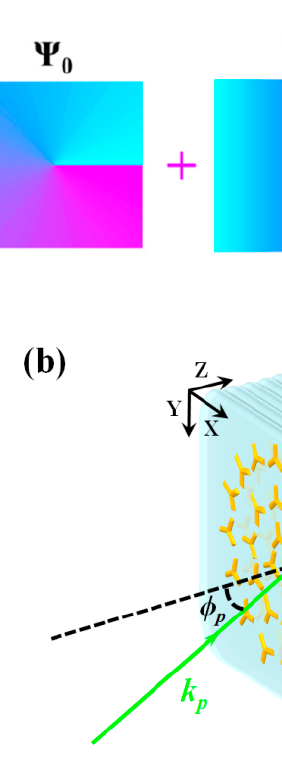
Figure 3. ( a ) Constructing the total distribution function Ψ tot of meta-atom orientation. ( b ) The principle of PDC process in the nonlinear metamaterial with the distribution Ψ tot . The pump light is obliquely launched to ensure a high transformation efficiency.